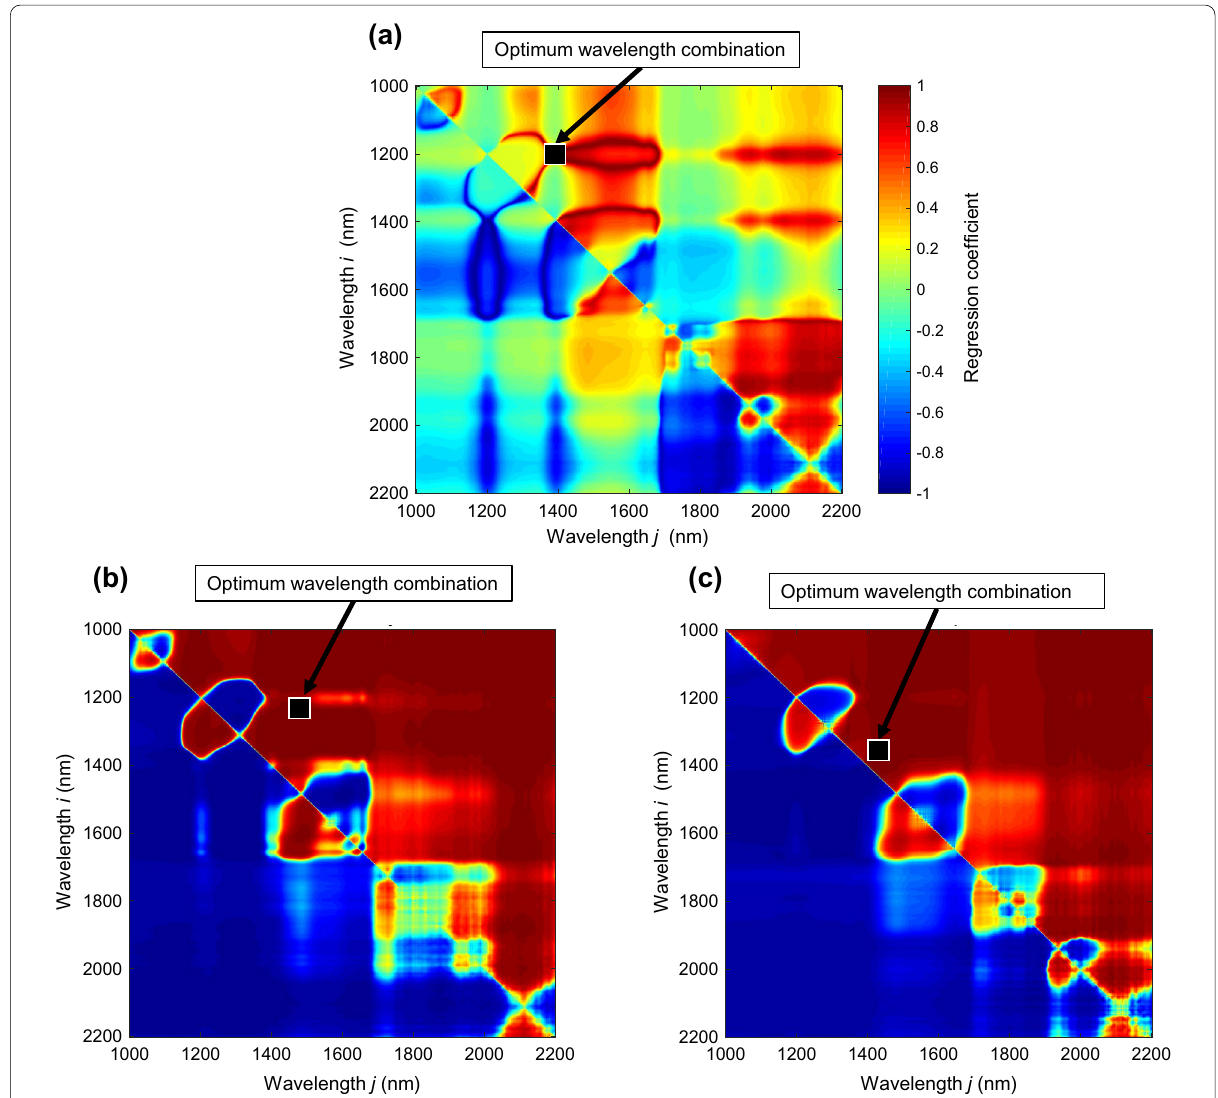
Fig. 5 The 2D images of the regression coefficient ( R ) between CNF addition ratio and the raw absorbance quotients of all wavelengths combination ( t ij ): a all, b injection shape, and c film shape samples. The details of sample conditions and t ij are shown in Table 1 and Eq. (1), respectively. The y and x axis show the wavelengths i and j in Eq. (1)